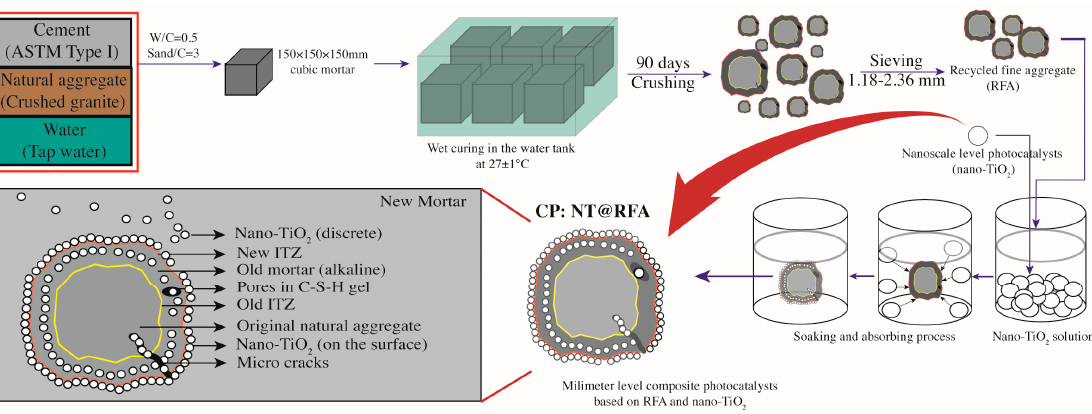
Figure 2. Schematic diagram of the preparation procedures of NT@FRA and the structure of final NT@FRA.